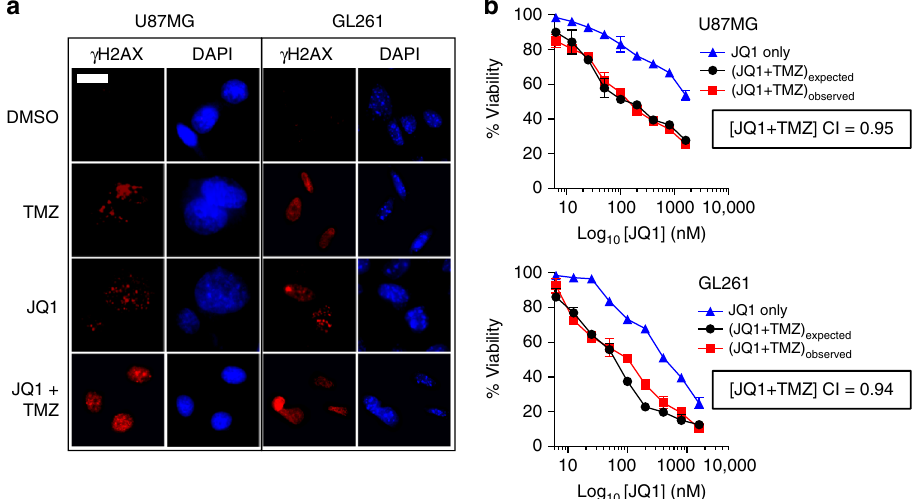
Fig. 3 The bromodomain inhibitor JQ1 and temozolomide have additive effects in U87MG and GL261 glioma cells. a Representative immuno fl uorescence images of γ H2AX DNA damage foci in U87MG and GL261 cells treated with 500 nM JQ1 and/or 150 μ M TMZ for 72 h. Scale bar = 10 μ m. b Cell viability plots demonstrating combinatorial effects of JQ1 and TMZ. Combinatorial index (C.I.) values determined using the Chou – Talalay method. Data presented as mean ± SEM of three separate